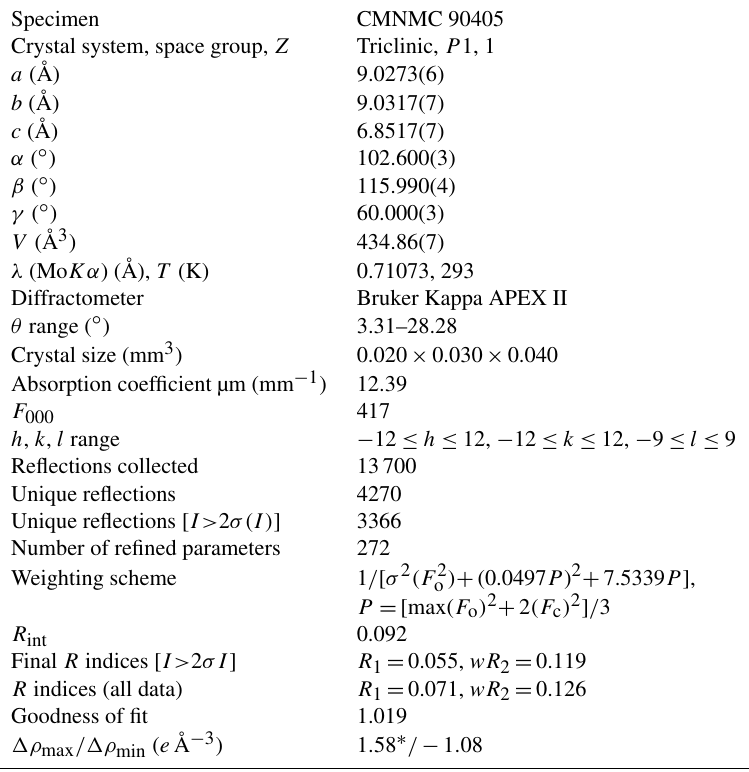
Table 5. Crystal data, data collection information, and structure refinement details for donnayite-(Y).